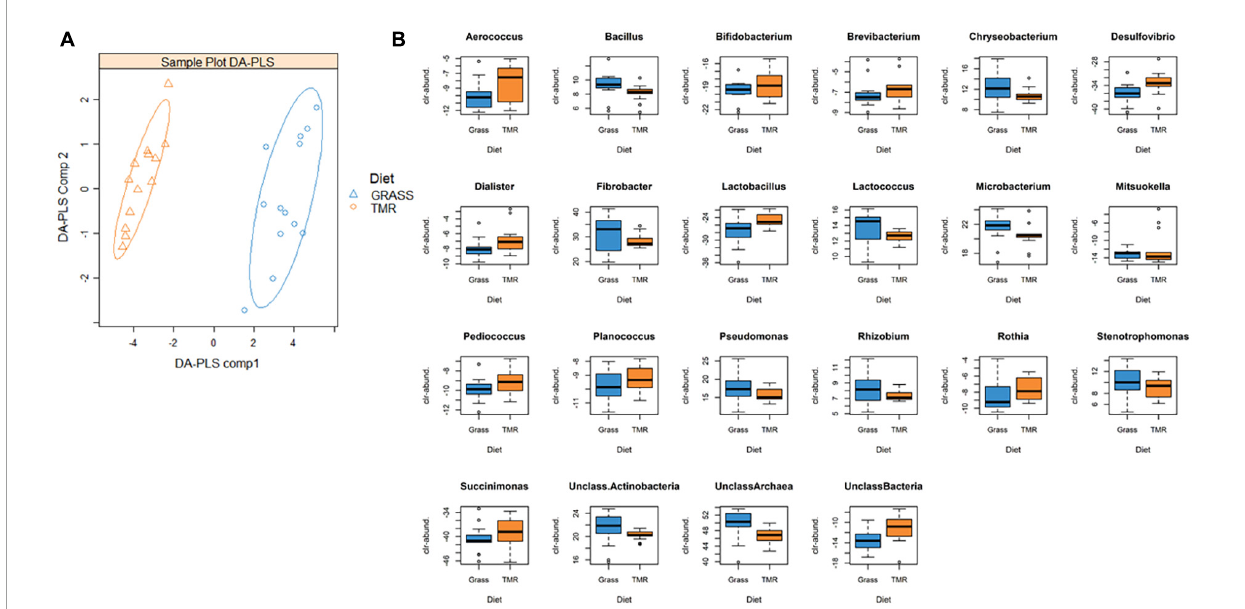
FIGURE1 (A) Sample plot from a Discriminant by projection of latent structures analysis (DA-PLS) fitted to discriminate amongst the fresh cut grass (Grass) and high concentrate (TMR) fed animals based on 28 clr-transformed microbial genera abundances. The model was built with a single component and presented a miss-classification rate of 0%. For visualization purposes, sample plot is based on two components. (B) Microbial genera identified by DA-PLS which presented differential abundances between grass and TMR (probability of the difference of being different from 0 ≥ 0.95). Differences are expressed in units of clr-transformed abundances. Full details of the PLS analysis and linear models can be found in Supplementary Table 1 .